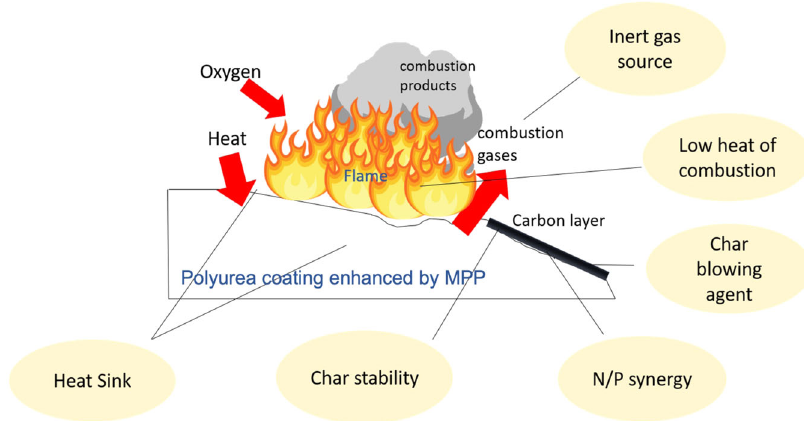
Fig. 7 Melamine-based fi re-retardant combustion stages.